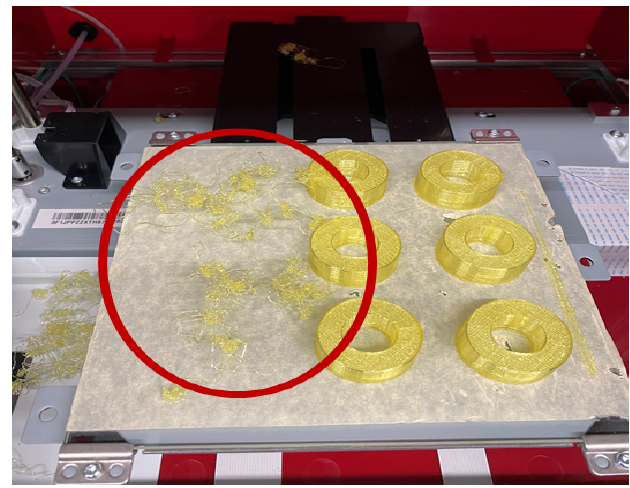
Figure 7. Spaghetting of unsuccessful deposition of the melted filament material.